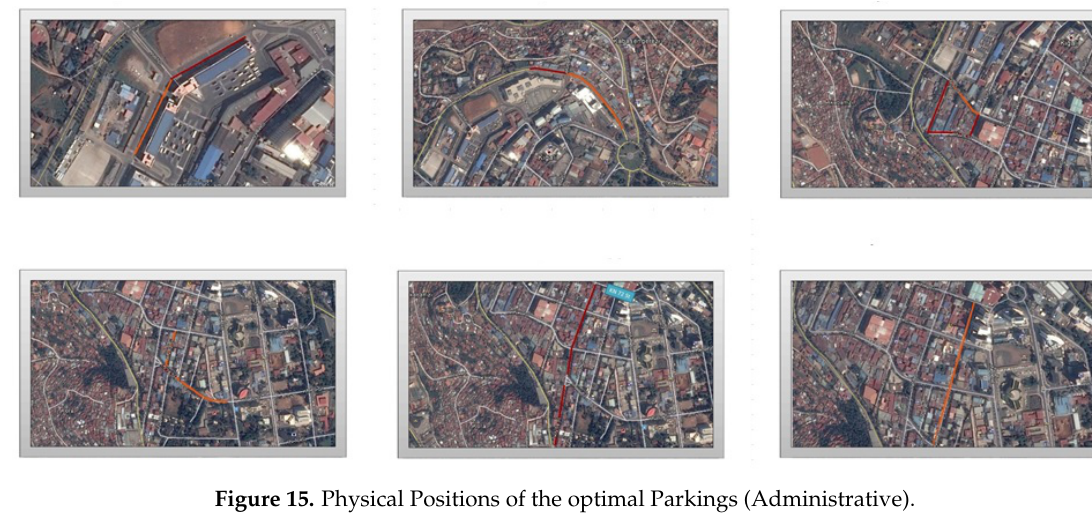
Figure 15. Physical Positions of the optimal Parkings (Administrative).